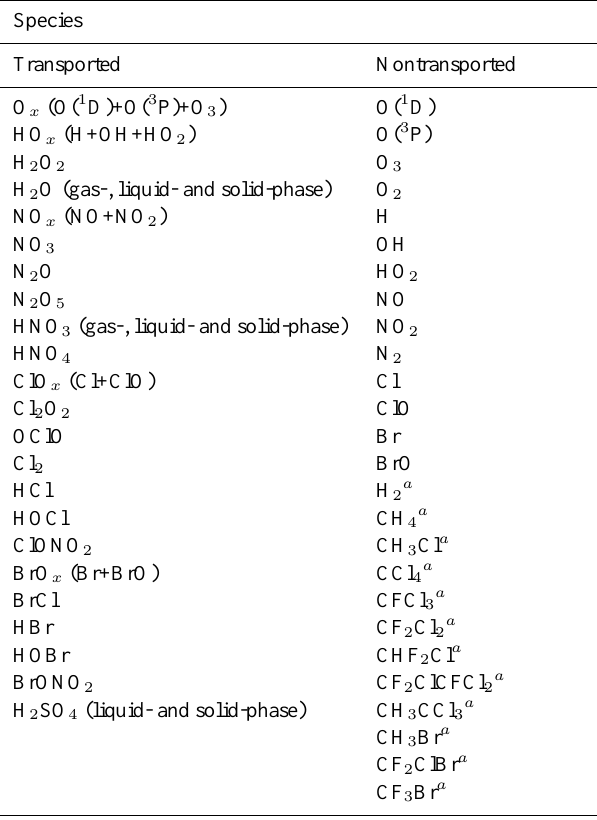
Table 1. Chemical constituents and families included in the model Species